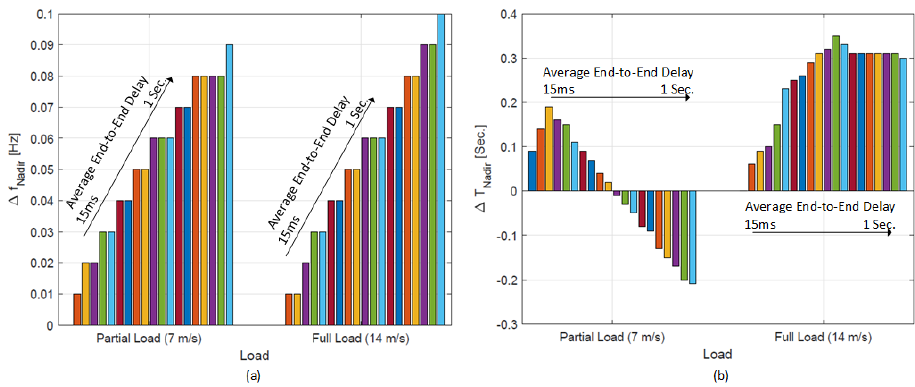
Figure A1. For Test Scenario 2, figure showing a trend in ( a ) f Nadir and ( b ) T Nadir in comparison with that of reference frequency response under a sequence of increasing end-to-end network delay.